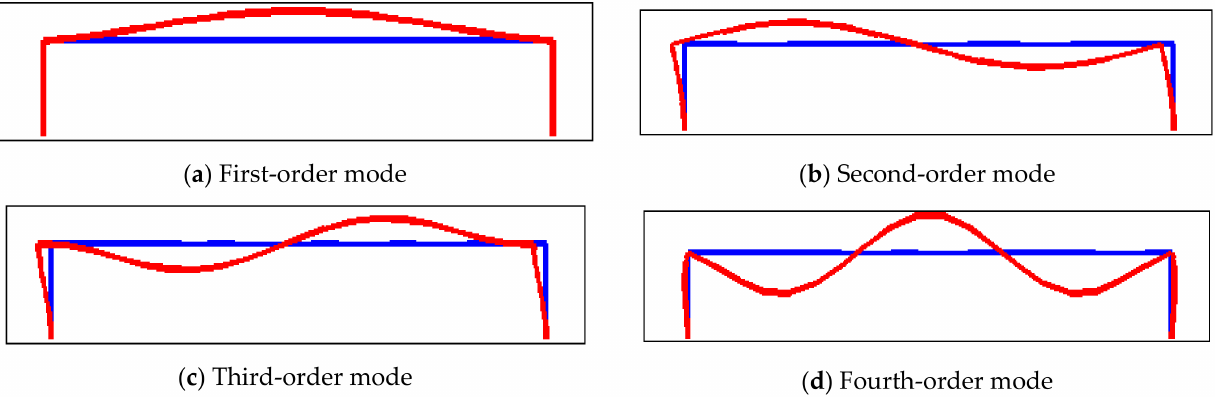
Figure 10. The mode diagram of the resonator structure with double-ended fixed support: ( a ) first-order mode; ( b ) second- order mode; ( c ) third-order mode; ( d ) fourth-order